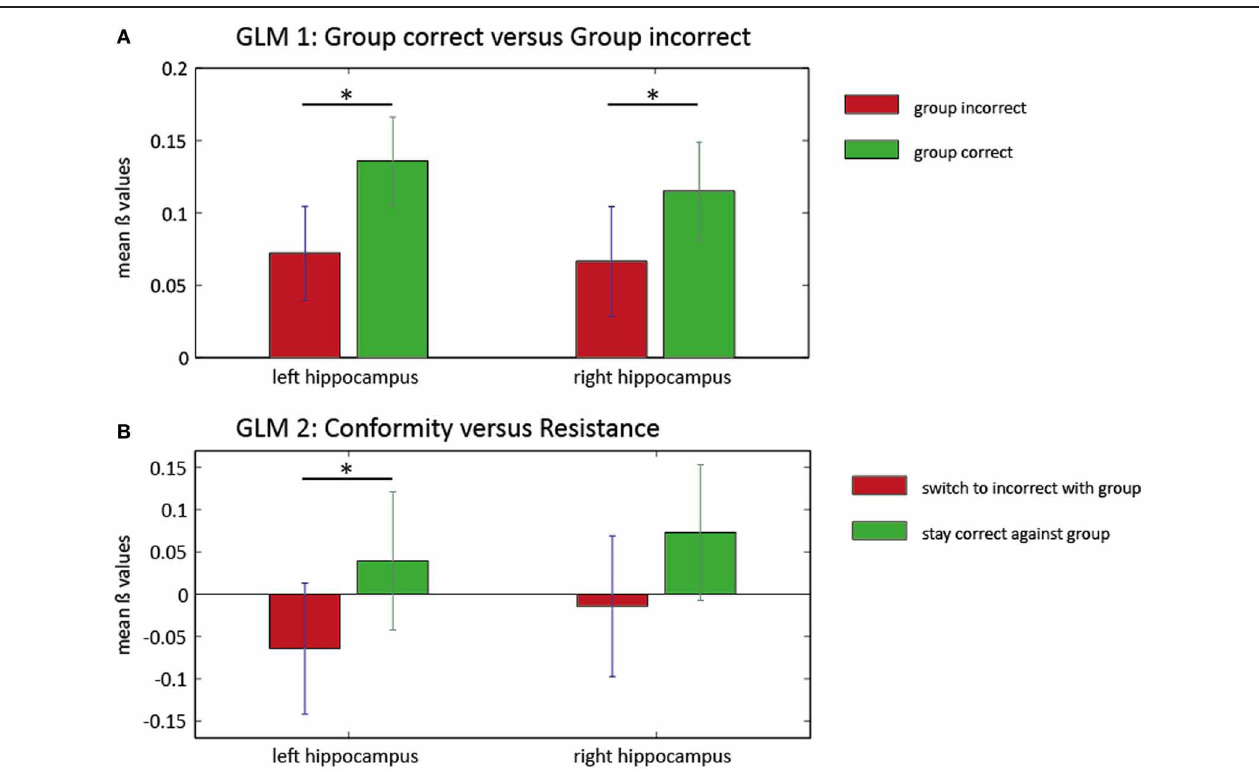
∗ T ( ∗ T ( 27 ) = 3 . 1805, P = 0 . 004; right panel: 27 ) = 2 . 5586, P = 0 . 016. The second GLM (B) reveals increased activity in the left hippocampus when subjects resist the group (green) compared with trials where conforming responses were given (red). There was no significant increase of activity in the right hippocampus for this contrast. Left panel: ∗ T ( 23 ) = 2 . 082, P = 0 . 049.